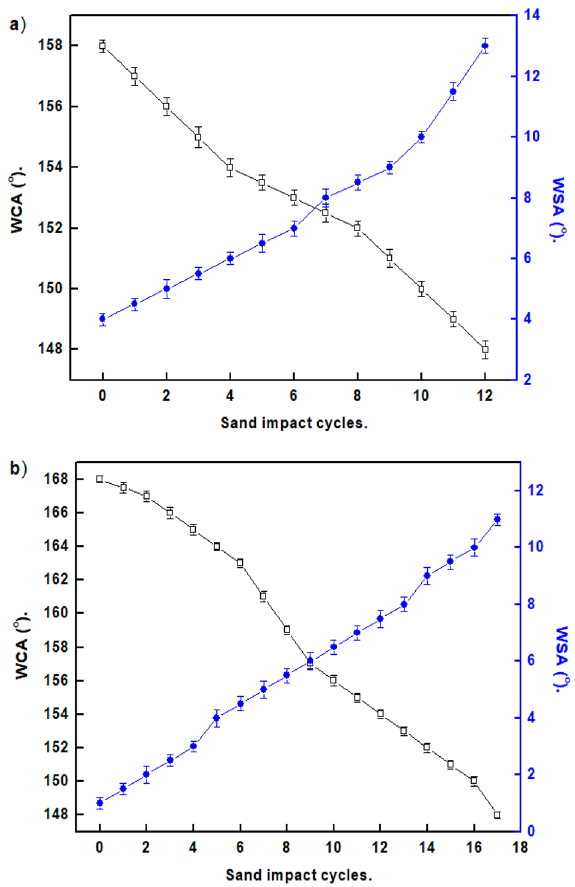
Figure 12. The effect of sand impact cycles on the WCAs and WSAs of coated steel with ( a ) Ni@G@MA and ( b )